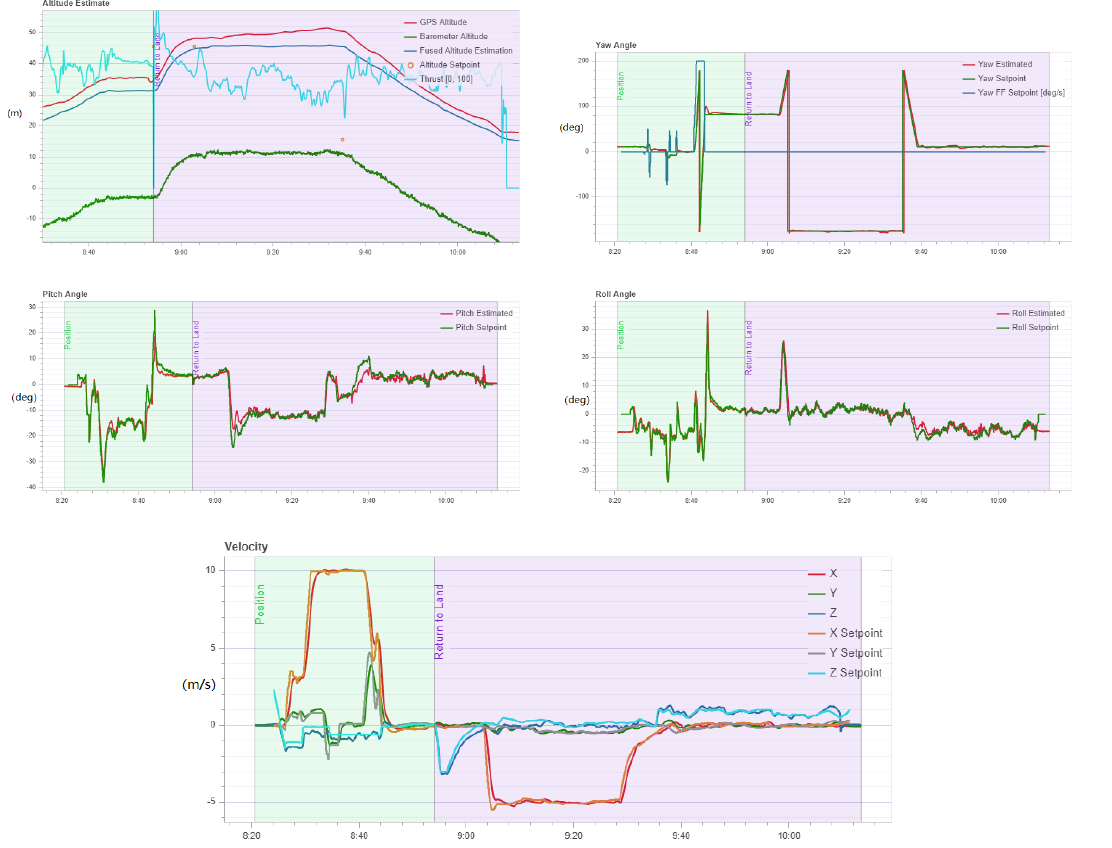
Figure 4. Altitude and attitude variation of the quadrotor during the simulation of the transportation